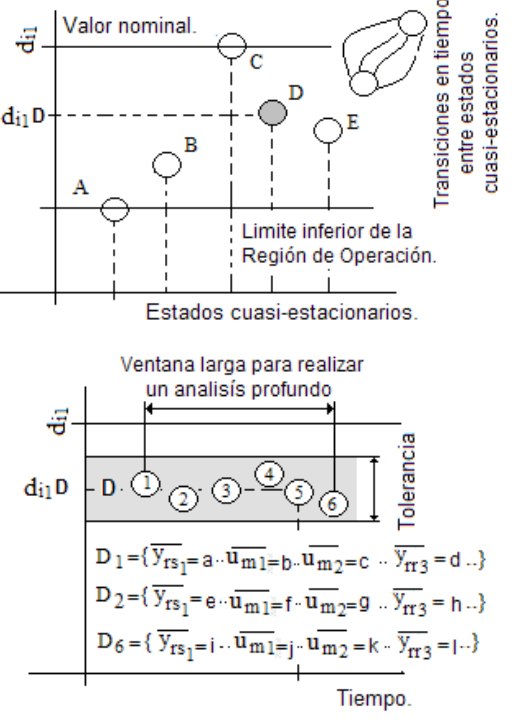
Figura 2 – Estados cuasi-estacionarios: comportamiento multivariable y multidimensional en función de una variable de carga y su variabilidad temporal en días: (a) d i1 vs conjunto de estados